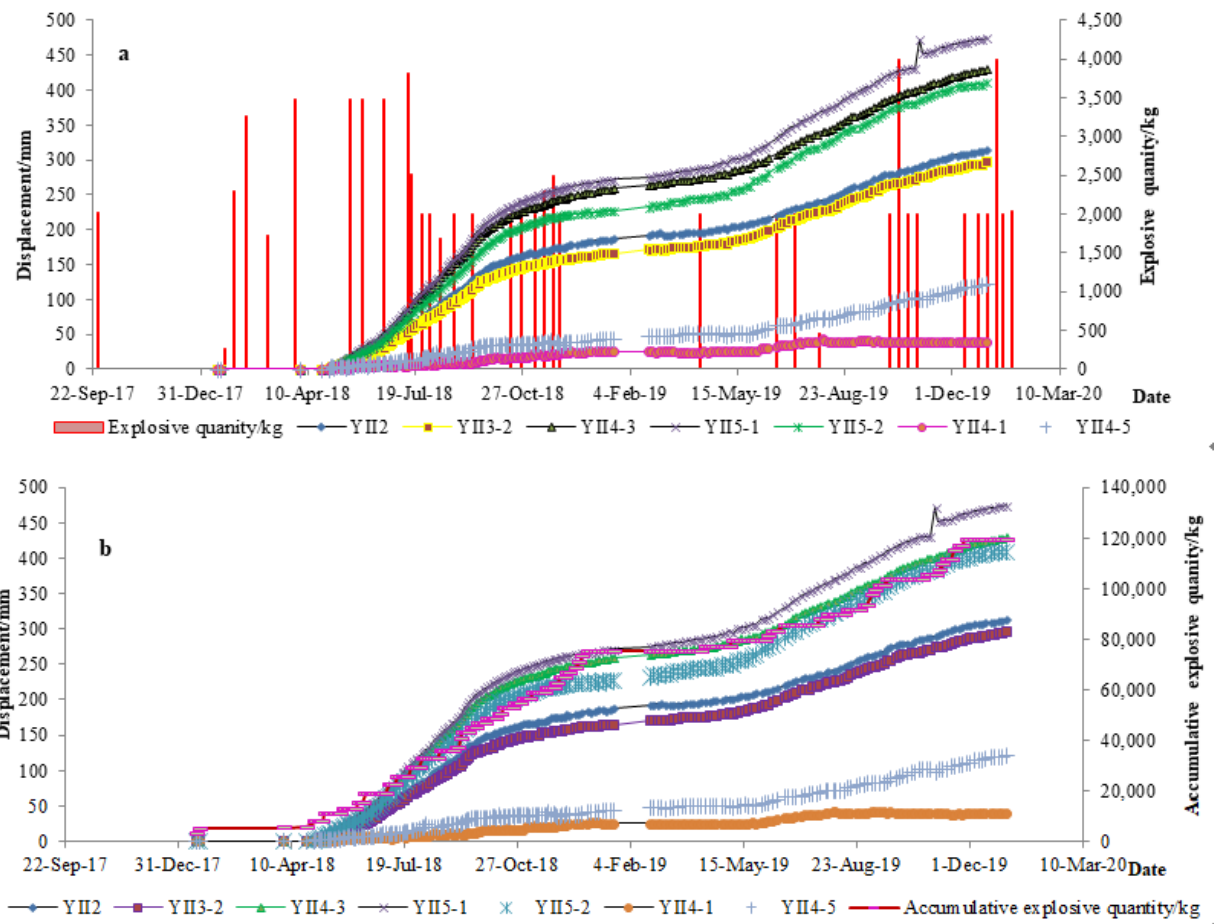
Figure 9. Explosive blasting and landslide displacement monitoring data: ( a ) displacement with daily blasting and ( b ) displacement with cumulative blasting.